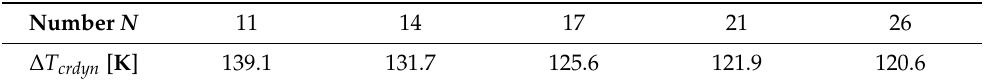
Table 2. Critical dynamic temperature differences ∆ T cr of axisymmetrical FDM plate model ( m = 0) loaded thermally with a positive gradient versus a different number N of discrete